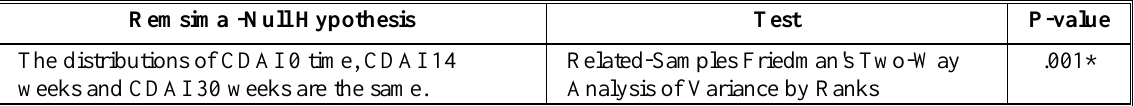
Table 5-A. The difference in CDAI scores across three measures before (baseline) and after Remsima treatment (14 weeks and 30 weeks post-therapy).